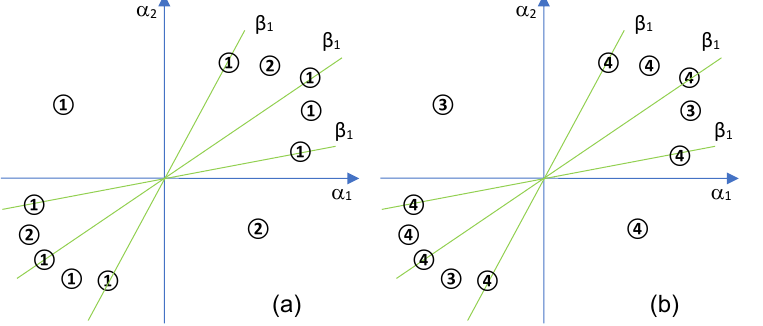
Figure 9. Bifurcation diagrams when p < 0, r < 0, and ∆ 2 < 0: ( a ) a > 0, h < 0, L 0 > 0 or a < 0, h < 0, L 0 > 0; ( b ) a > 0, h < 0, L 0 < 0 or a < 0, h < 0, L 0 <